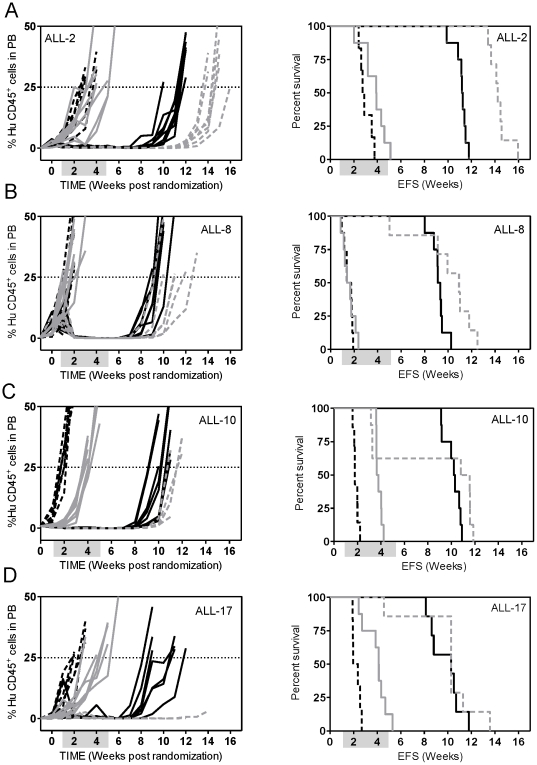

In vivo sensitivity of ALL xenografts to VXL and VXL/ABT-737 combination treatments.Female mice were engrafted with: ALL-2 (A); ALL-8 (B); ALL-10 (C); or ALL-17 (D) and treated with a diluent vehicle (controls, dashed black lines), ABT-737 (25 mg/kg, solid grey lines), VXL combination (solid black lines), or VXL+ABT-737 quadruple combination (dashed grey lines). Engraftment kinetics indicated by %huCD45+ cells in PB of individual mice (left panel) and Kaplan-Meier survival curves (EFS) (right panel) are shown. Shaded boxes represent the treatment period. All events were leukemia-related except for 1 and 4 in the VXL/ABT-737-treated group of the ALL-8, and ALL-10, respectively. In the ALL-17 quadruple drug combination cohort all mice were culled due to leukemia or toxicity unrelated morbidity.